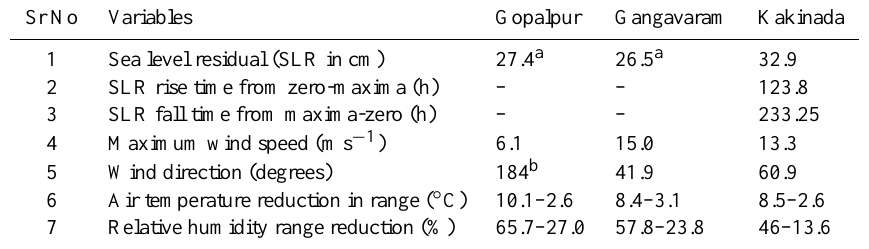
Table 3. Meteorological and sea level observations at Gopalpur, Gangavaram and Kakinada during E2 from 26–31 December 2011. Sr No